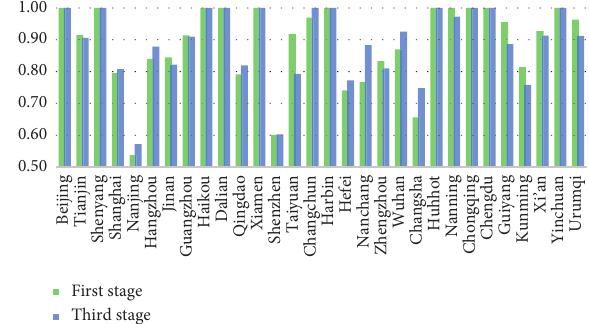
Figure 4: Comparison of average pure technical efficiency before and after adjustment (2010–2016).